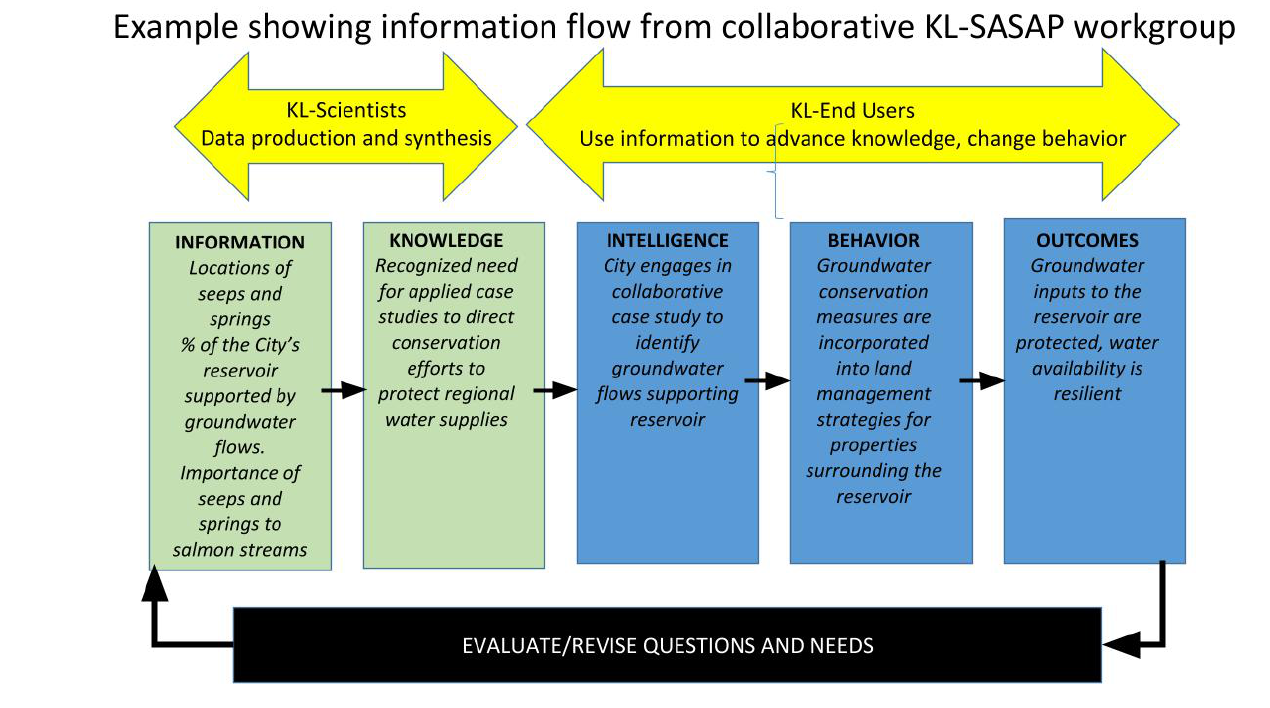
Fig. 8. Flowchart demonstrating the iterative flow of information from scientists to stakeholders in a collaborative project to enable meaningful decision-making based on science. This figure was derived from a concept diagram created by Jude Apple, after a Kachemak Bay National Estuarine Research Reserve science collaborative